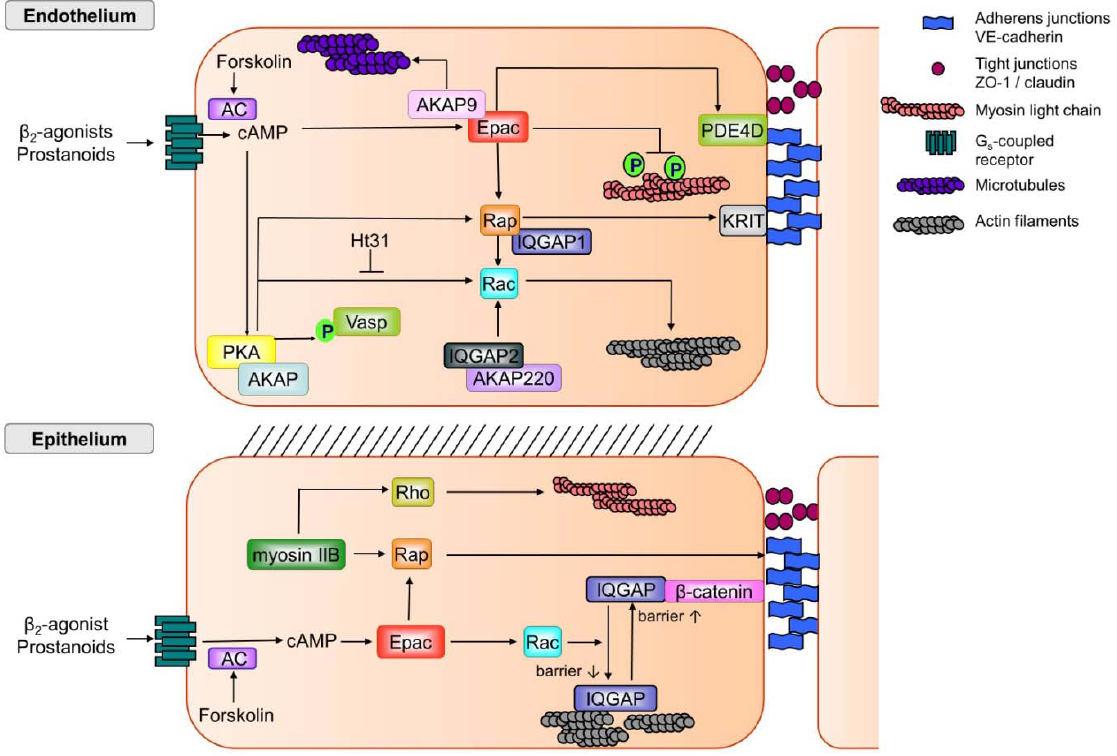
Figure 3. cAMP signalling in endothelial cells vs. epithelial cells. β